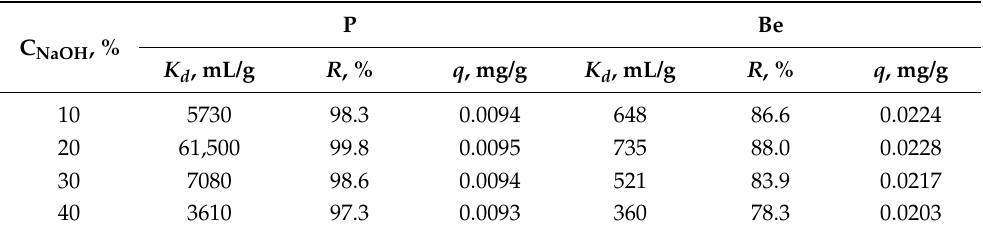
Table 2. Influence of the NaOH concentration used for alkaline hydrolysis in the production of Fe-H on the sorption parameters of phosphorus and beryllium. C NaOH ,